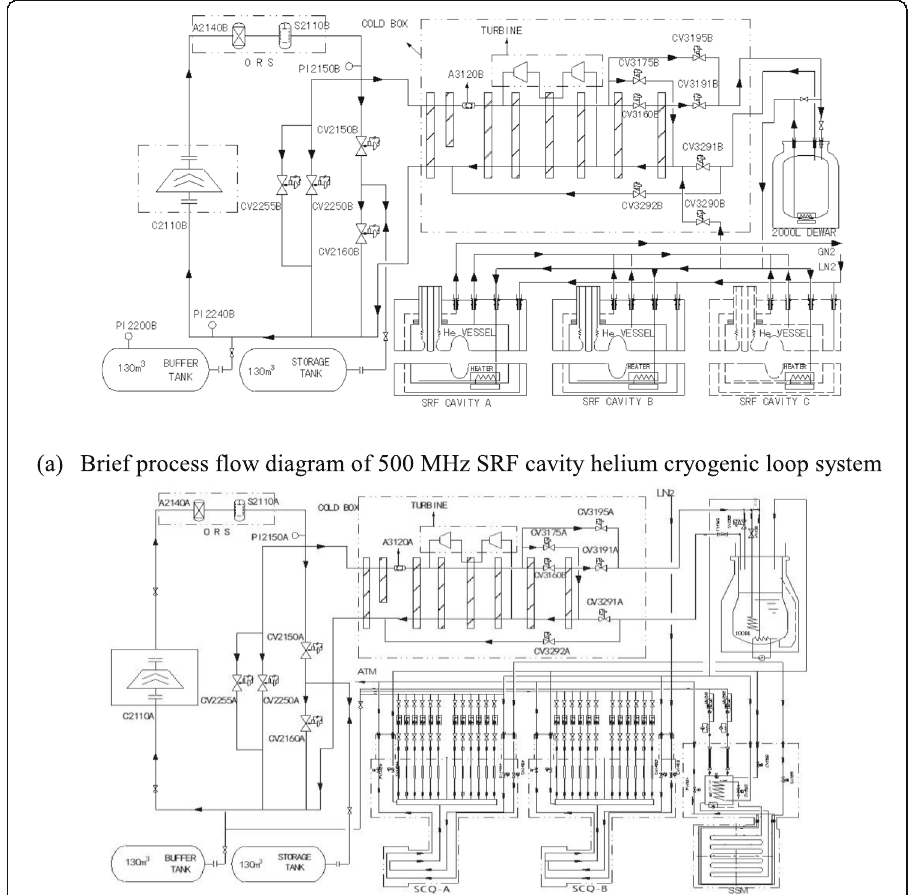
Fig. 3 The process flow diagrams of BEPCII cryogenic loop